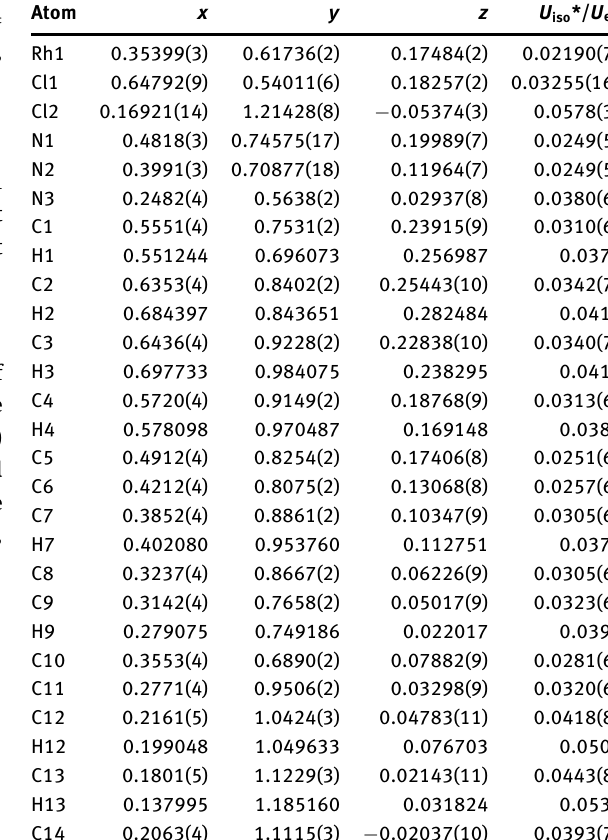
Table 2: Fractional atomic coordinates and isotropic or